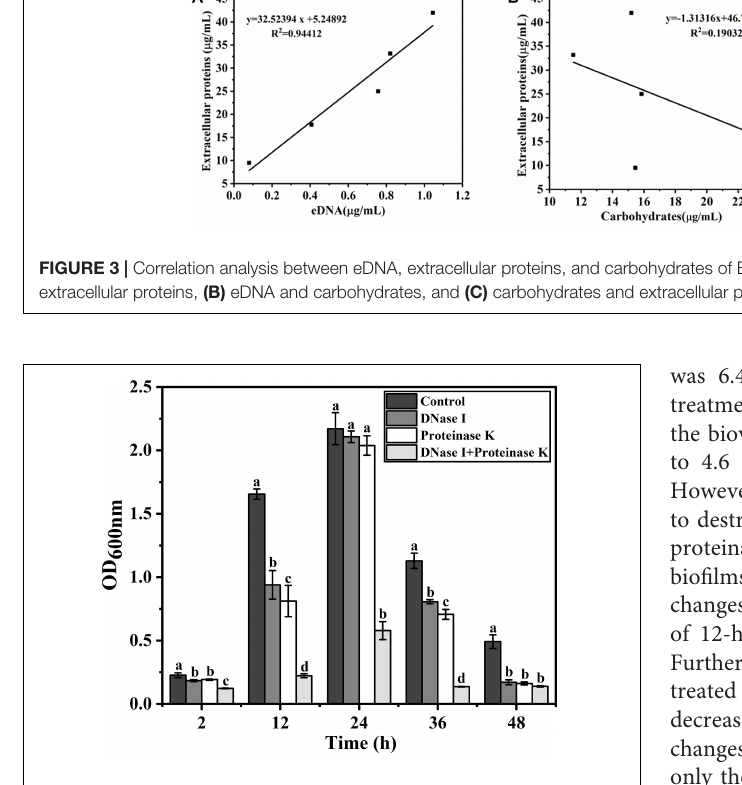
FIGURE 4 | Effect of eDNA and extracellular proteins on biofilm formation of V. parahaemolyticus . To confirm whether the eDNA and extracellular proteins serve as structural components in biofilms of V. parahaemolyticus , DNase I, proteinase K, and their combination were added to the biofilms incubated at different times (2, 12, 24, 36, and 48 h). Error bars show standard deviations of three independent experiments, and the different letters represent significant differences among treatments ( P <